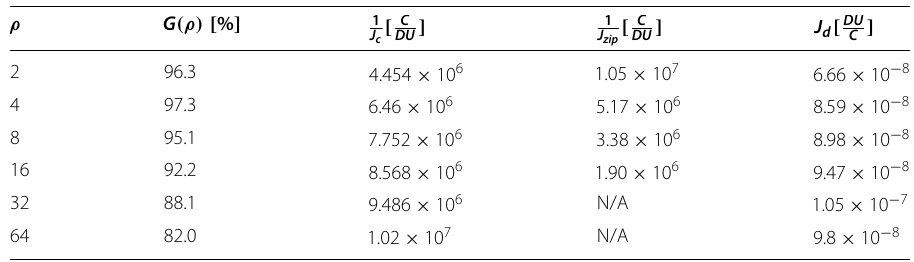
Table 2 LUT parameters for the deep-CE